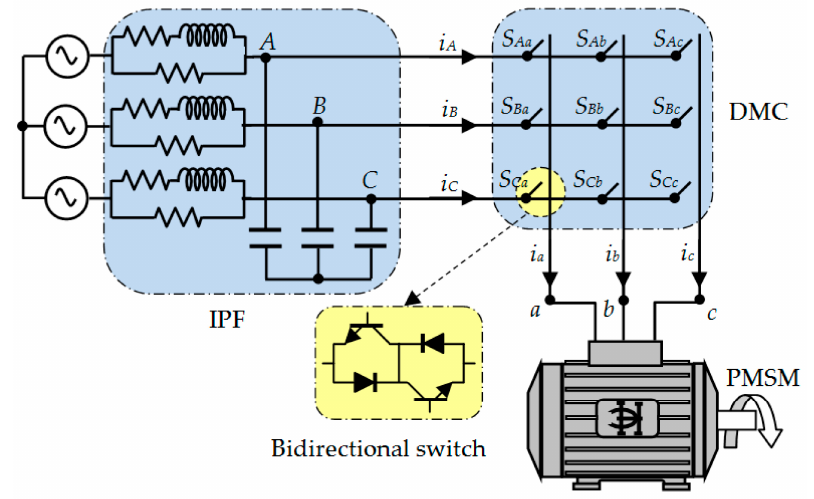
Figure 1. Descriptive diagram of DMC fed PMSM drive system.